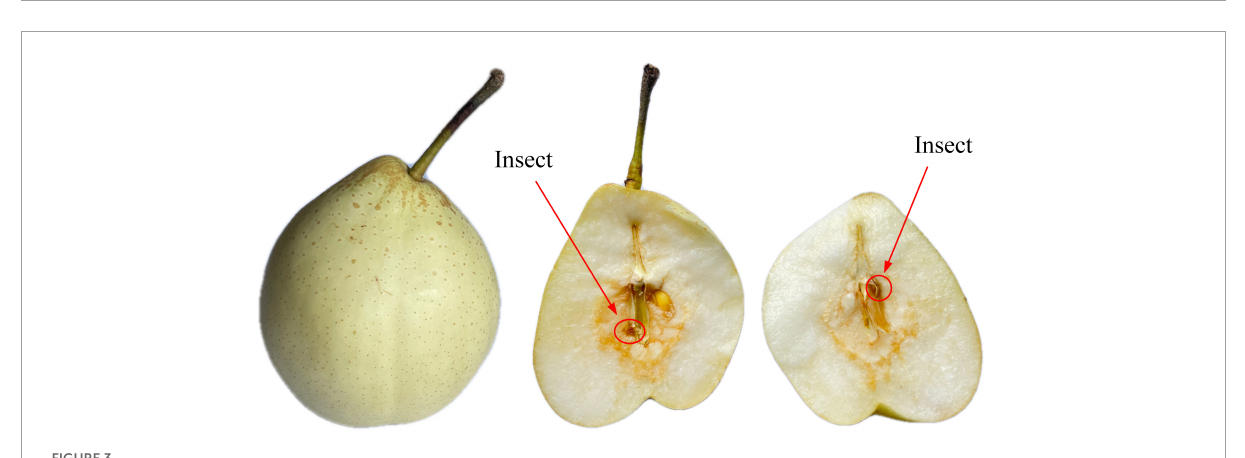
FIGURE3 Insect-affected Yali pear